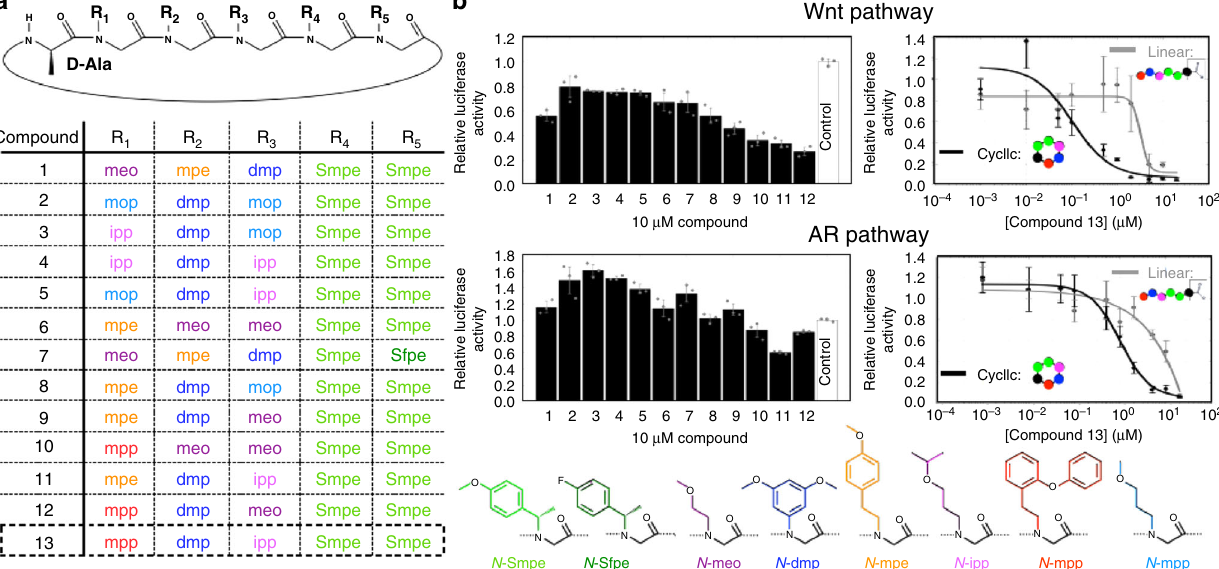
Fig. 2 Design of oligomer macrocylces to bind β -catenin. a Peptoid – peptide hybrid macrocycle backbone scaffold. Middle table details compound number list and chemical compositions. Bottom section details the chemical compositions of peptoid side chains. b Luciferase reporter assay of compounds relative to a “ vehicle ” control. Data are presented as mean and SD ( n = 3). Notes: “ N- meo ” : N -(methoxy-ethyl)-glycine, “ N- mpe ” : N -(4-methoxy-phenyl-ethyl)- glycine, “ N- dmp ” : N -(3,5-dimethoxy-phenyl)-glycine, “ N- Smpe ” : N -((S)-4-methoxy-phenyl-ethyl)-glycine, “ N- Sfpe ” : N -((S)-4- fl uoro-phenyl-ethyl)-glycine, “ N- mpp ” : N -(2-phenoxy-phenyl-ethyl)-glycine, “ N- ipp ” : N -(isopropoxy-propyl)-glycine, “ N- mop ” : N -(methoxy-propyl)-glycine